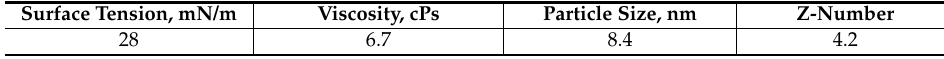
Table 3. Main parameters of the prepared inks.